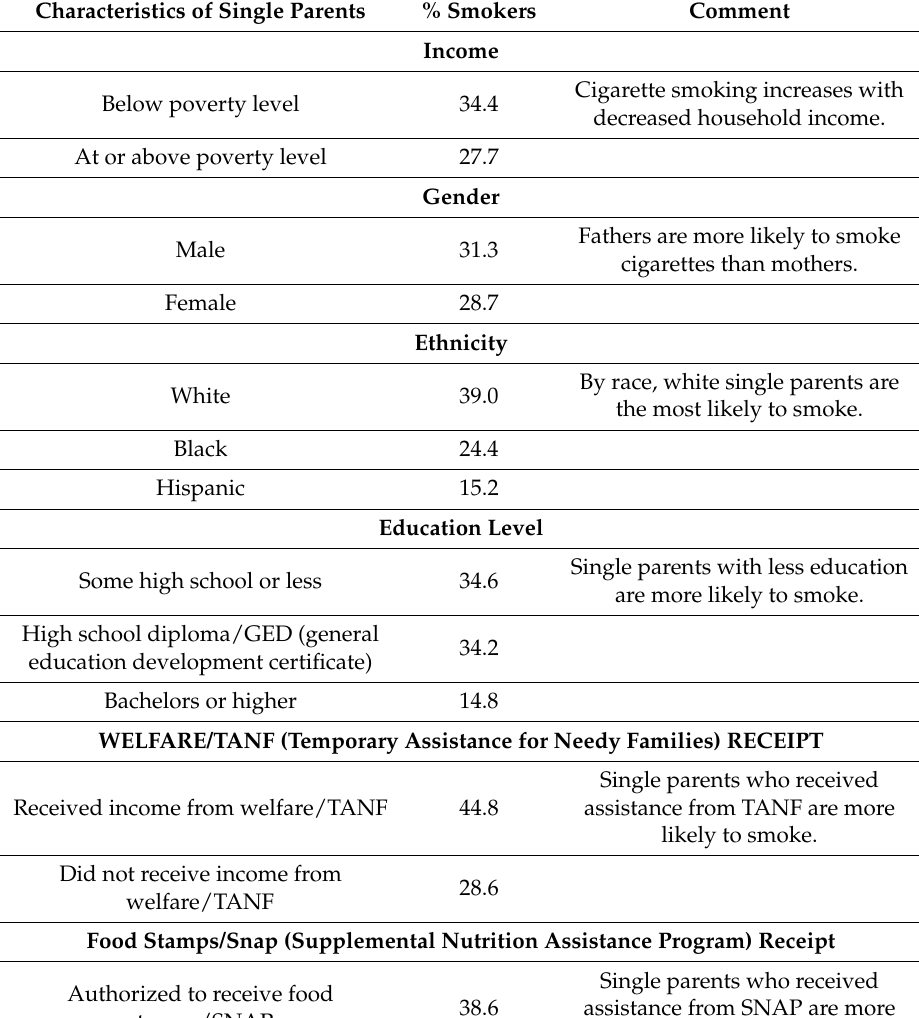
Table 2. Cigarette Smoking in Single